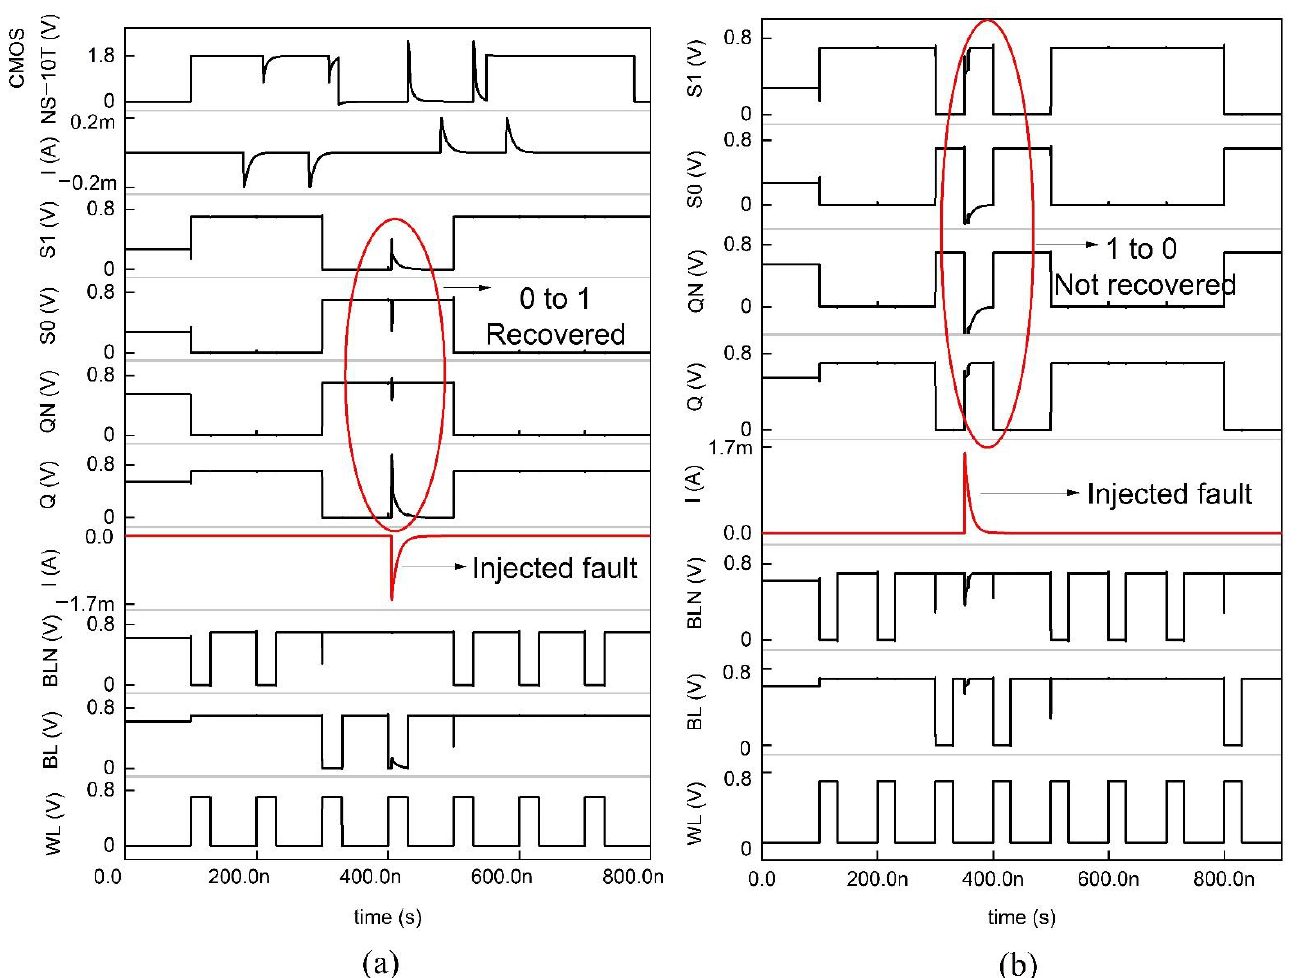
Figure 8. Timing and simulation of NS−10T where the fault is injected at node Q and QN is shown in ( a , b